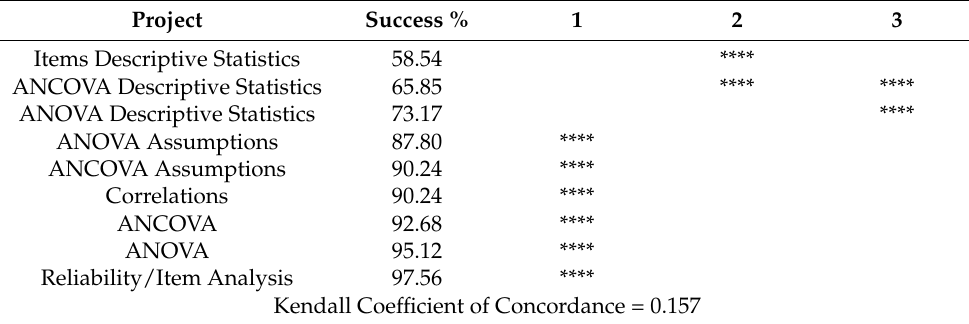
Table 10. Multiple comparisons for the particular phases of experimental